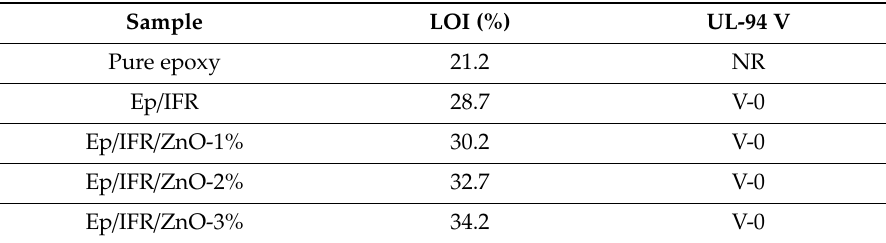
Table 3. LOI and UL-94 V ratings results of the